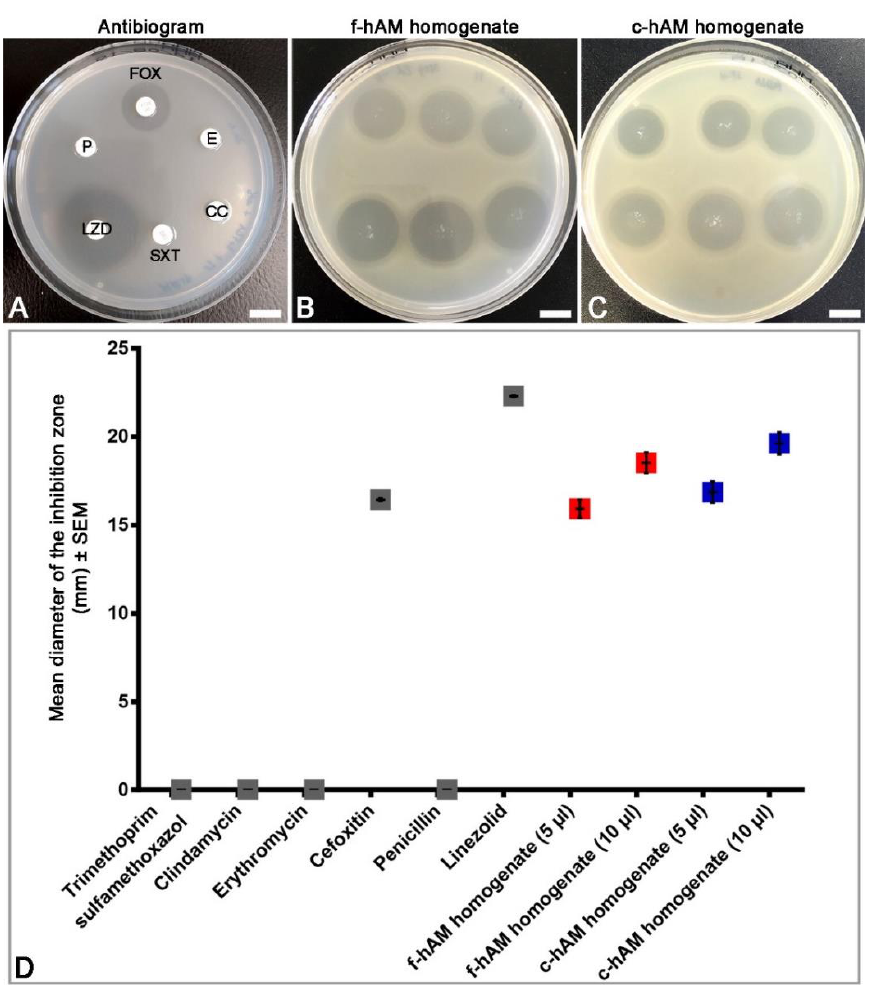
Figure 4. Comparison of the antibacterial activity of hAM homogenates and selected antibiotics against the reference strain of methicillin-resistant S. aureus (MRSA). ( A , D ) The reference strain of MRSA is resistant to trimethoprim/sulfamethoxazole, clindamycin, erythromycin, penicillin, and cefoxitin and is susceptible to linezolid. ( B – D ) The application of 5 and 10 μL f-hAM and c-hAM homogenates results in an inhibition zone. Scale bars: 10 mm.